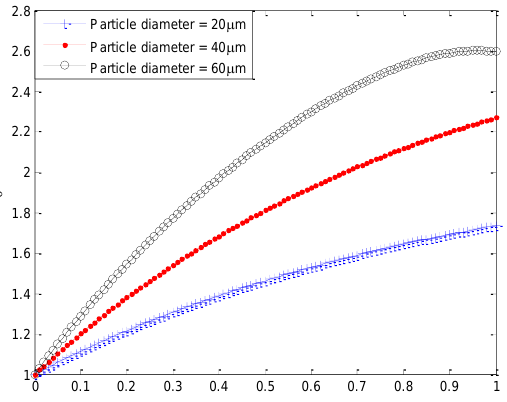
Fig. 2. Effect of particle diameter on the temperature Profile with